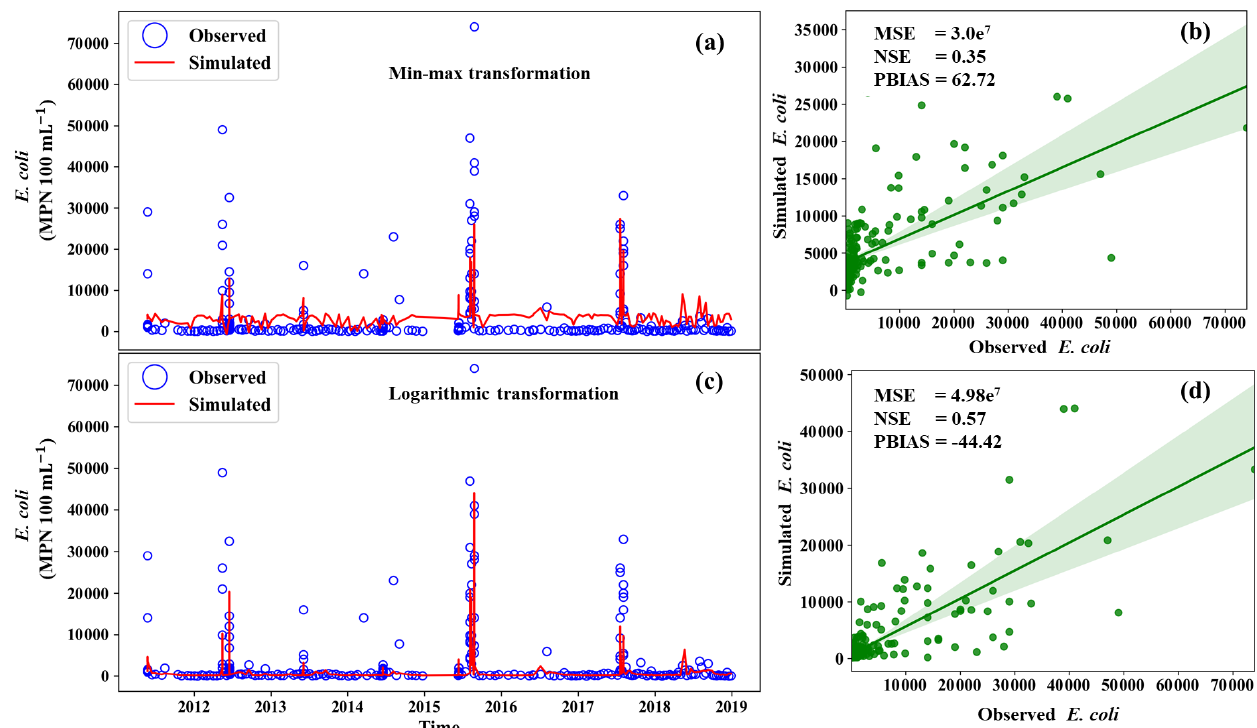
Figure 9. Comparison of E. coli concentration simulation with the transformation method: panels (a) and (c) indicate the E. coli simulation using min–max transformation and logarithmic transformation, respectively. Panels (b) and (d) indicate the scatter plot of E. coli using min–max transformation and logarithmic transformation, respectively.